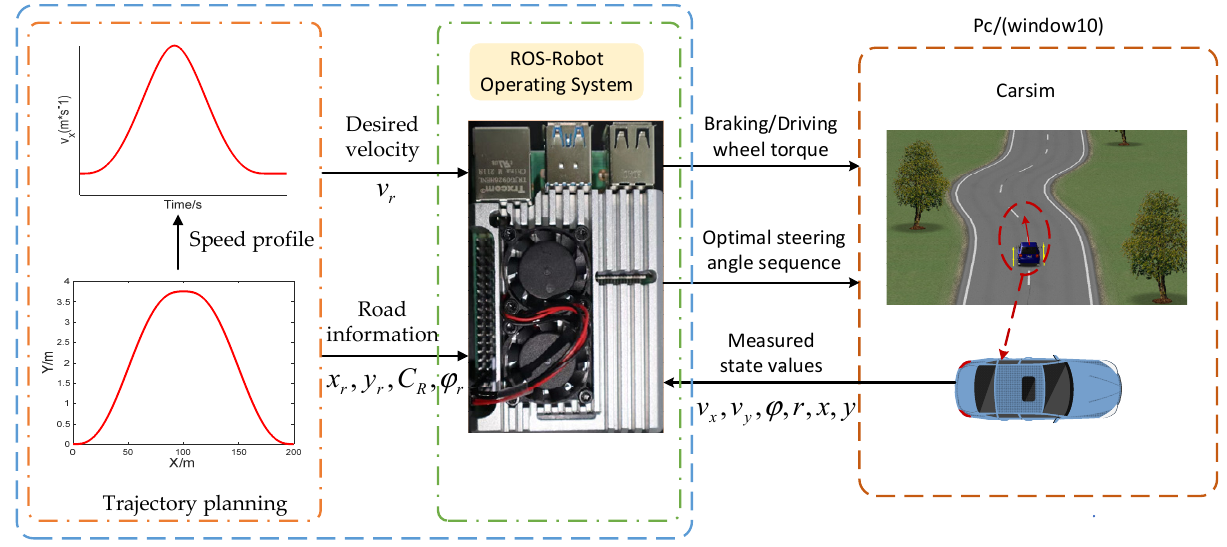
Figure 16. Hardware-in-loop platform. ROS runs on the Raspberry Pi 4B (CPU 64bit 1.5 GHz,8 GB Sto-rage) with the ub- untu18.4+ros melodic system, and CarSim runs on the same computer as Matlab (CPU i9-